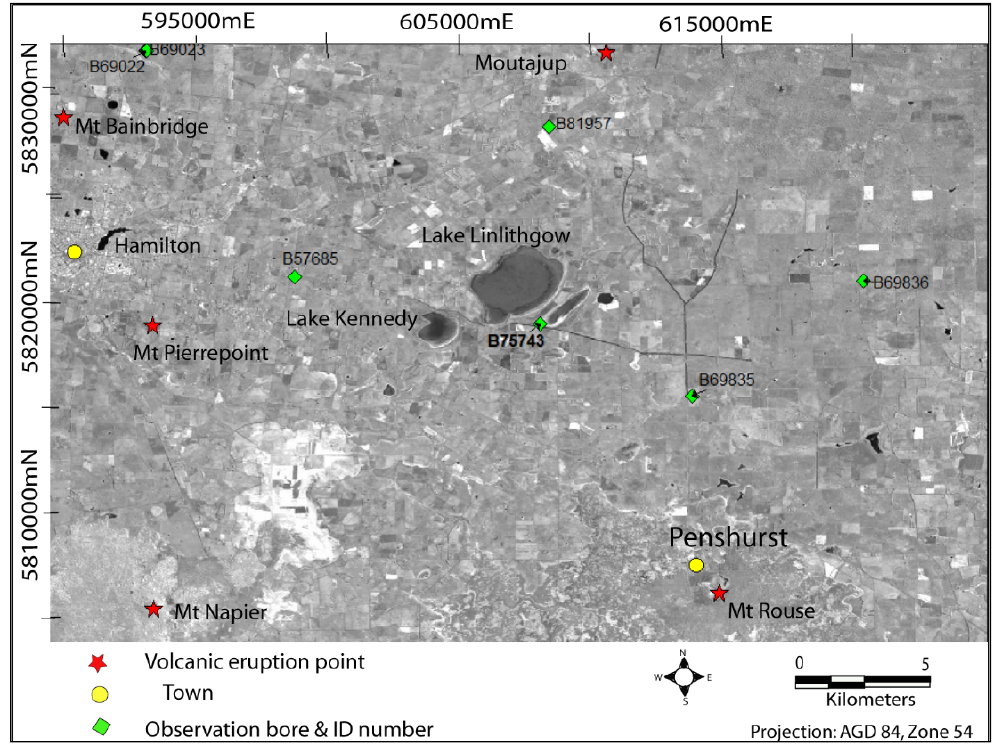
Figure 2. Landsat imagery (taken in February 2004) showing the Lake Linlithgow area.